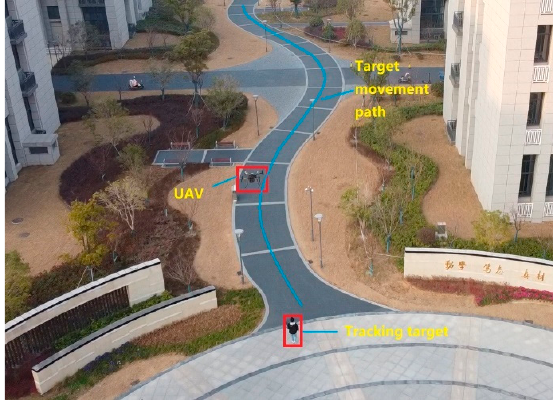
Figure 14. The scene of the tracking experiment.